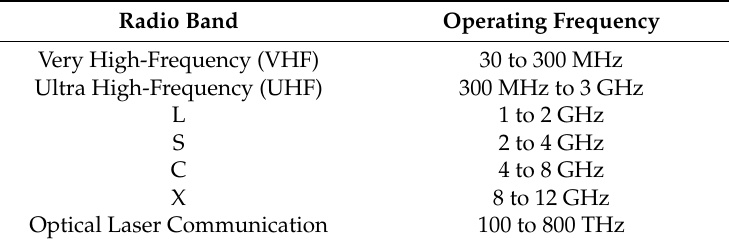
Table 13. Radio Frequency Operating Bands